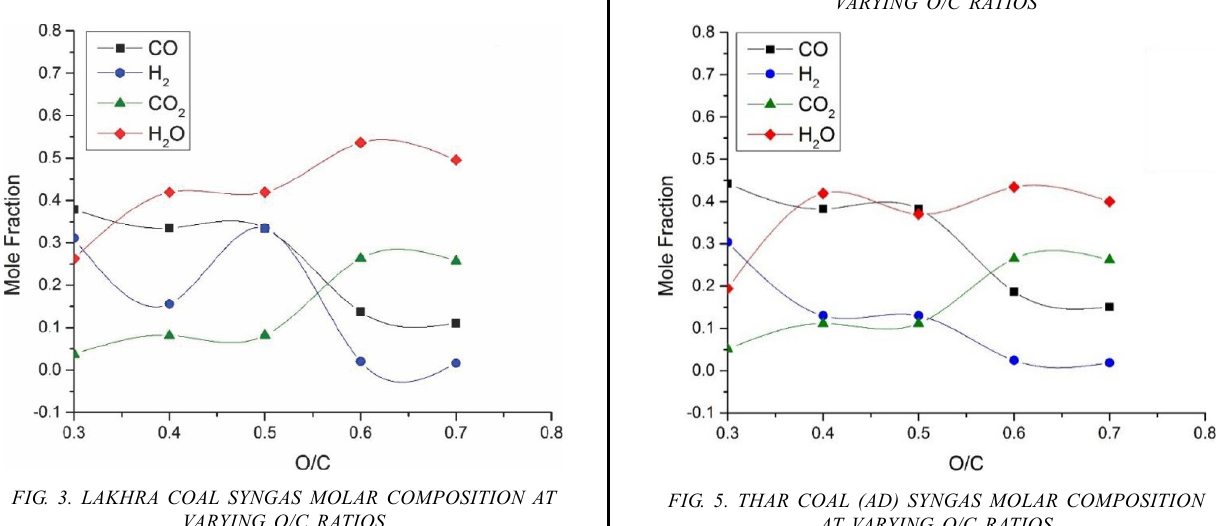
FIG. 5. THAR COAL (AD) SYNGAS MOLAR COMPOSITION AT VARYING O/C